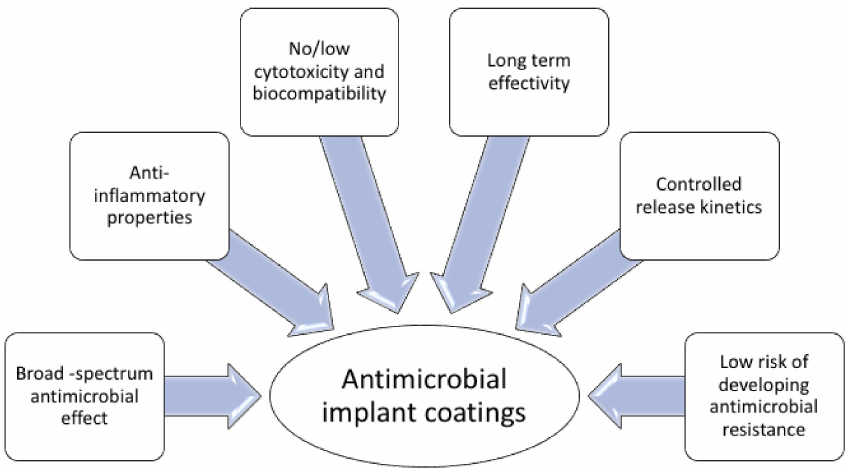
Figure 2. Requirements for antimicrobial coatings on medical